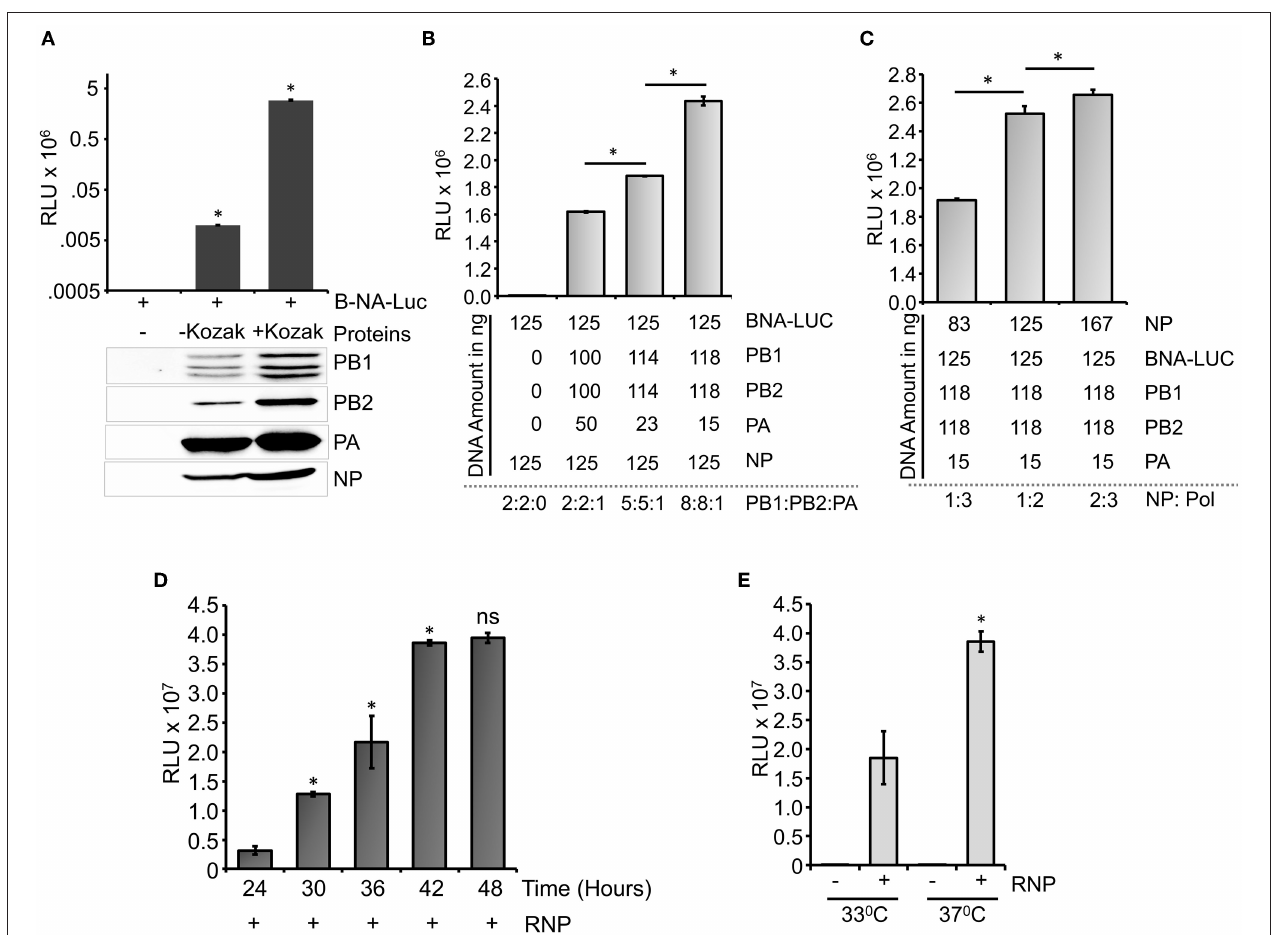
FIGURE 3 | Optimization of the reporter system: (A) An effect of Kozak sequence on the expression of viral polymerase proteins and influenza B RNP activity assay. (B) Reporter RNP activity assay with different ratios of the PA protein expression plasmid with respect to PB1 and PB2. (C) Reporter RNP activity assay with various amounts of NP expression plasmid. (D) Optimization of time for the reporter activity assay. (E) Optimization of incubation temperature for the influenza B RNP activity assay ( n = 3 ± standard deviation (SD), * p < 0.05 one-way analysis of variance (ANOVA) with post-hoc Student’s t -test when compared to the preceding set, for (E) , a comparison was performed between two RNP positive sets, ns, not